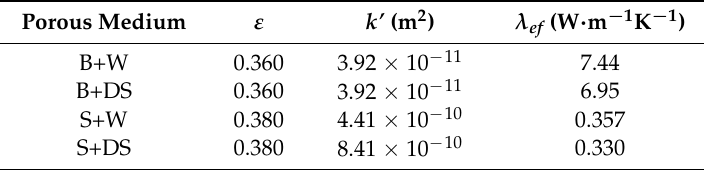
Table 3. Saturated porous media